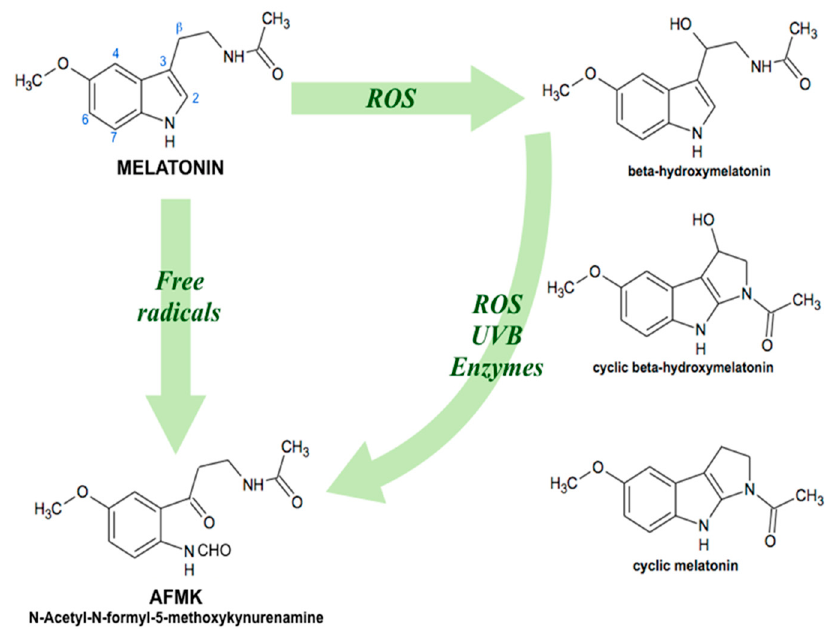
Figure 2. Antioxidant cascade of melatonin derivatives in plants. Melatonin can be hydroxylated at different C-atoms (2, 3, 4, 6, 7, β ) by subsequent interactions with two hydroxyl radicals. ROS, reactive oxygen species; UVB, ultraviolet B (shortwave) rays.